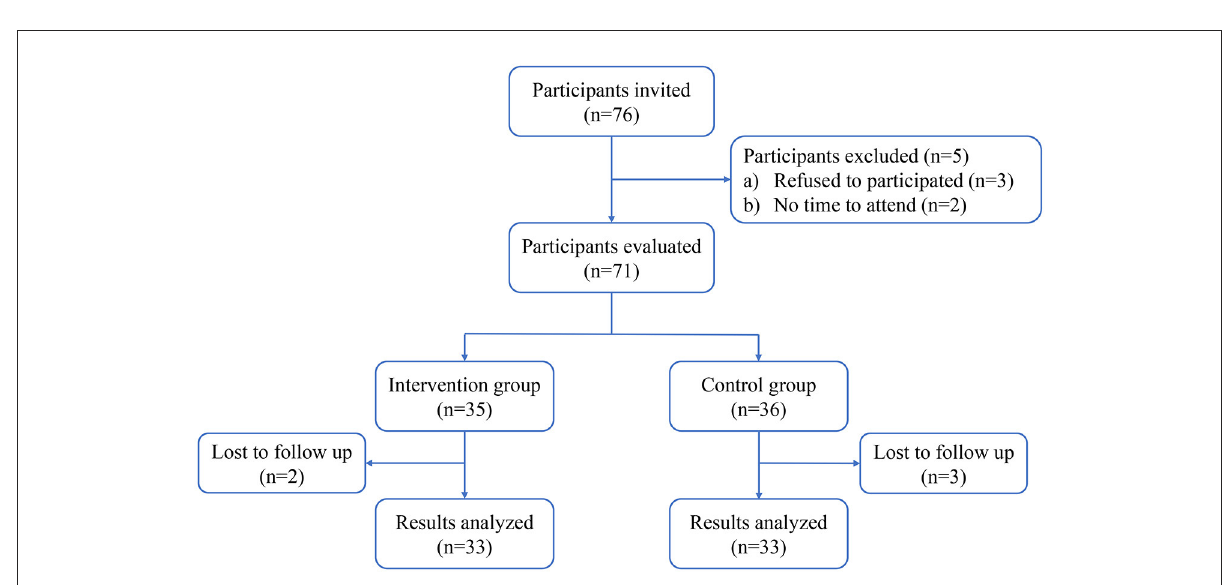
FIGURE1 Flow diagram of the